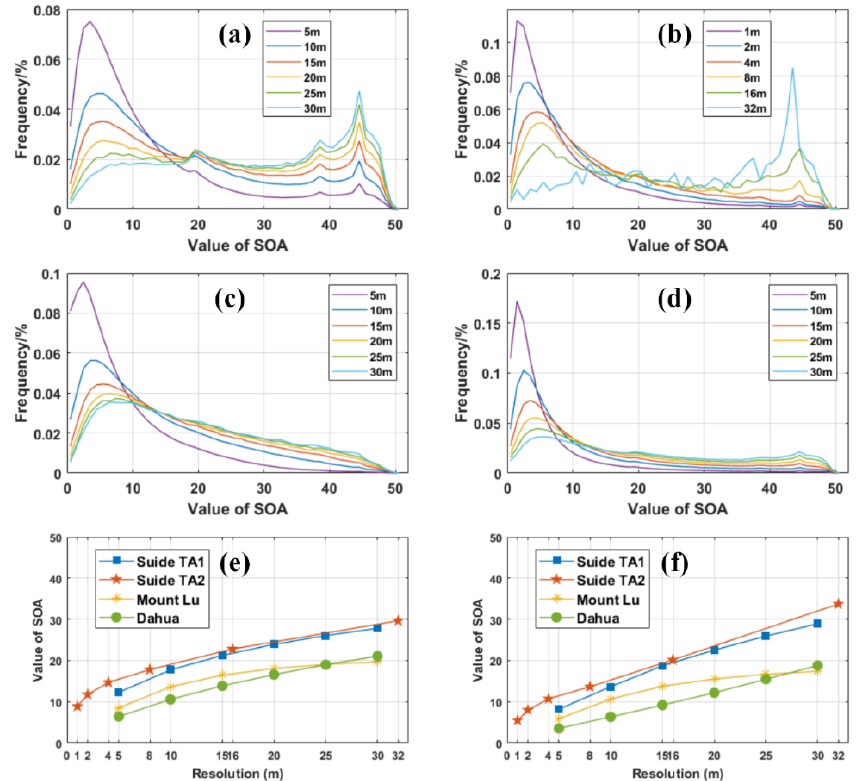
Figure 11. Statistics of the SoA results based on different resolutions using the vector method in different areas. ( a ) Suide TA1, ( b ) Suide TA2, ( c ) Mount Lu, ( d ) Dahua, ( e ) mean values, and ( f ) median values.